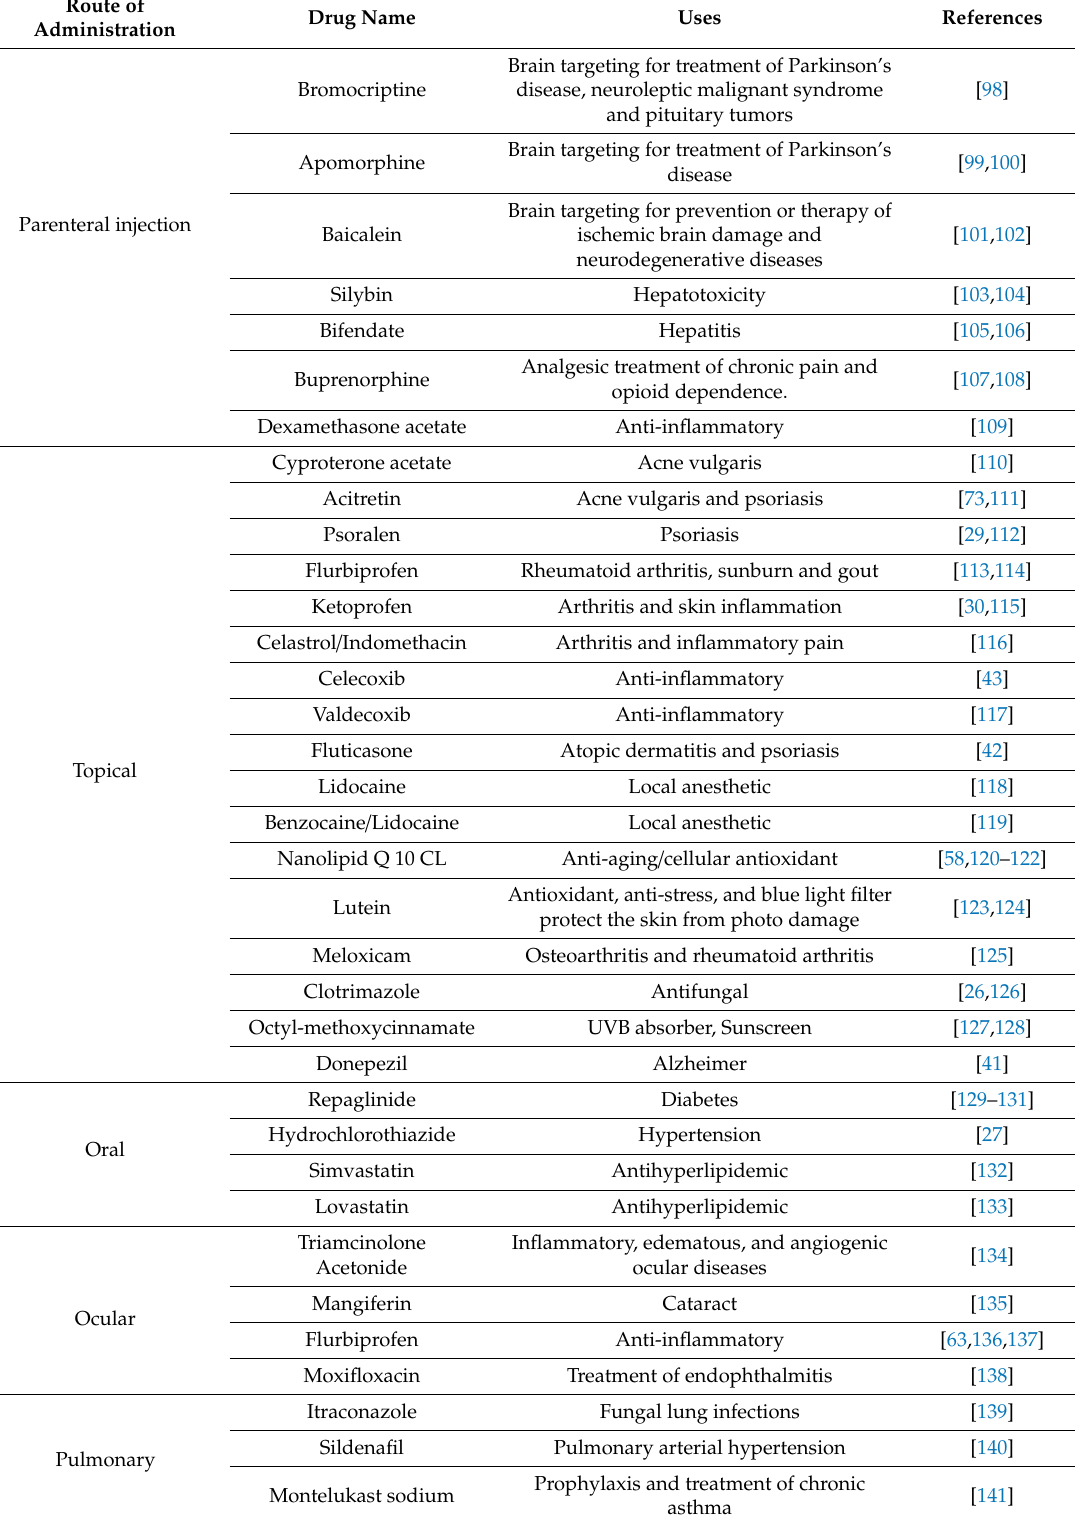
Table 2. Applications of NLCs in drug